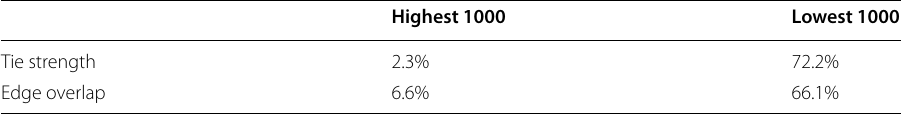
Table 5 Fractions of edges between